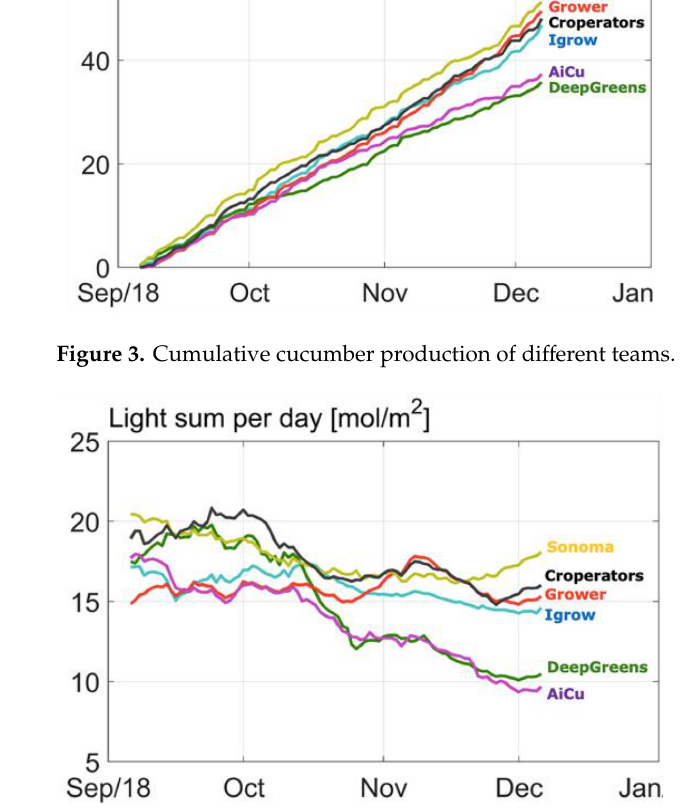
Figure 4. Course of total daily light integral in mol/m 2 inside the greenhouse just above the crop, composed of both artificial light and natural light, realized by different teams.